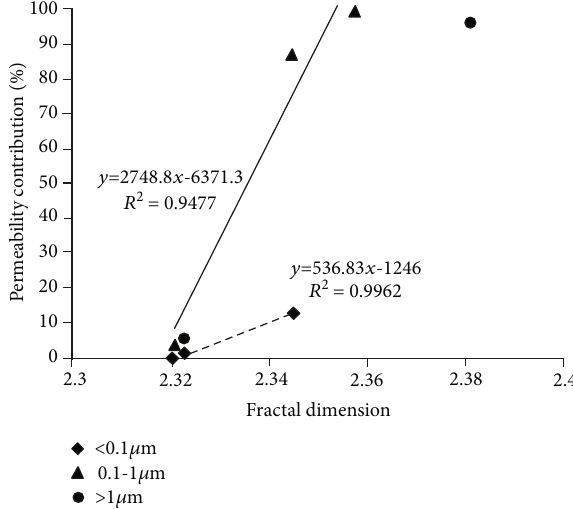
Figure 6: Relationship between fractal dimension of pore throats at di ff erent scales and permeability contribution.